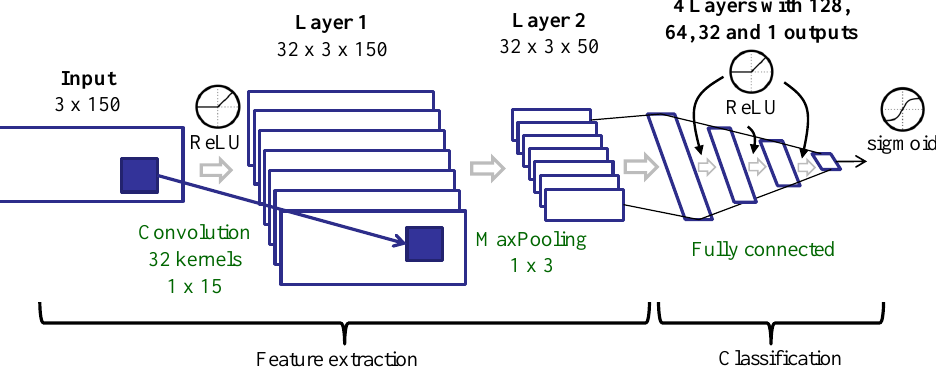
Figure 5. Deep learning architecture for training on raw